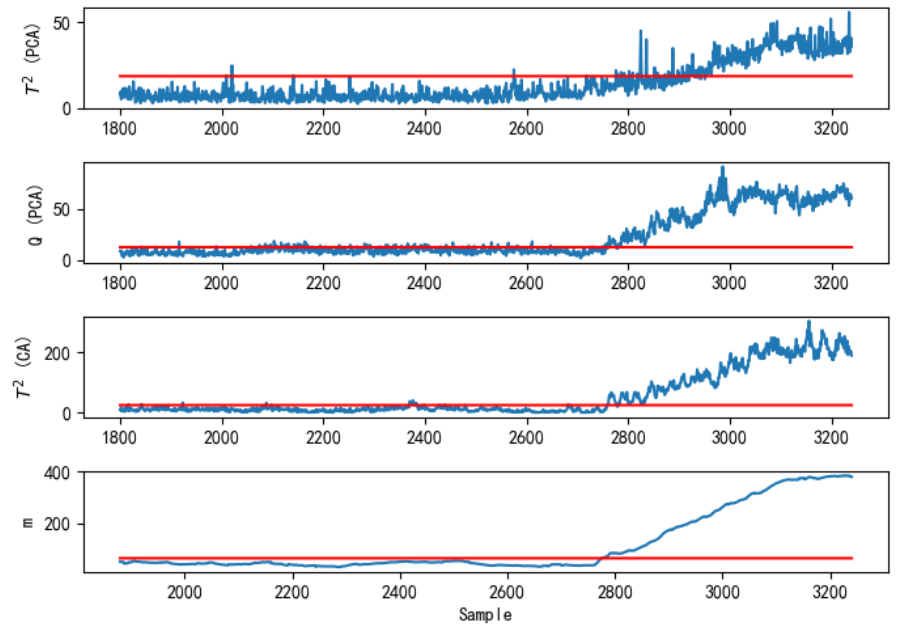
Figure 4. Monitoring results of the industrial process.